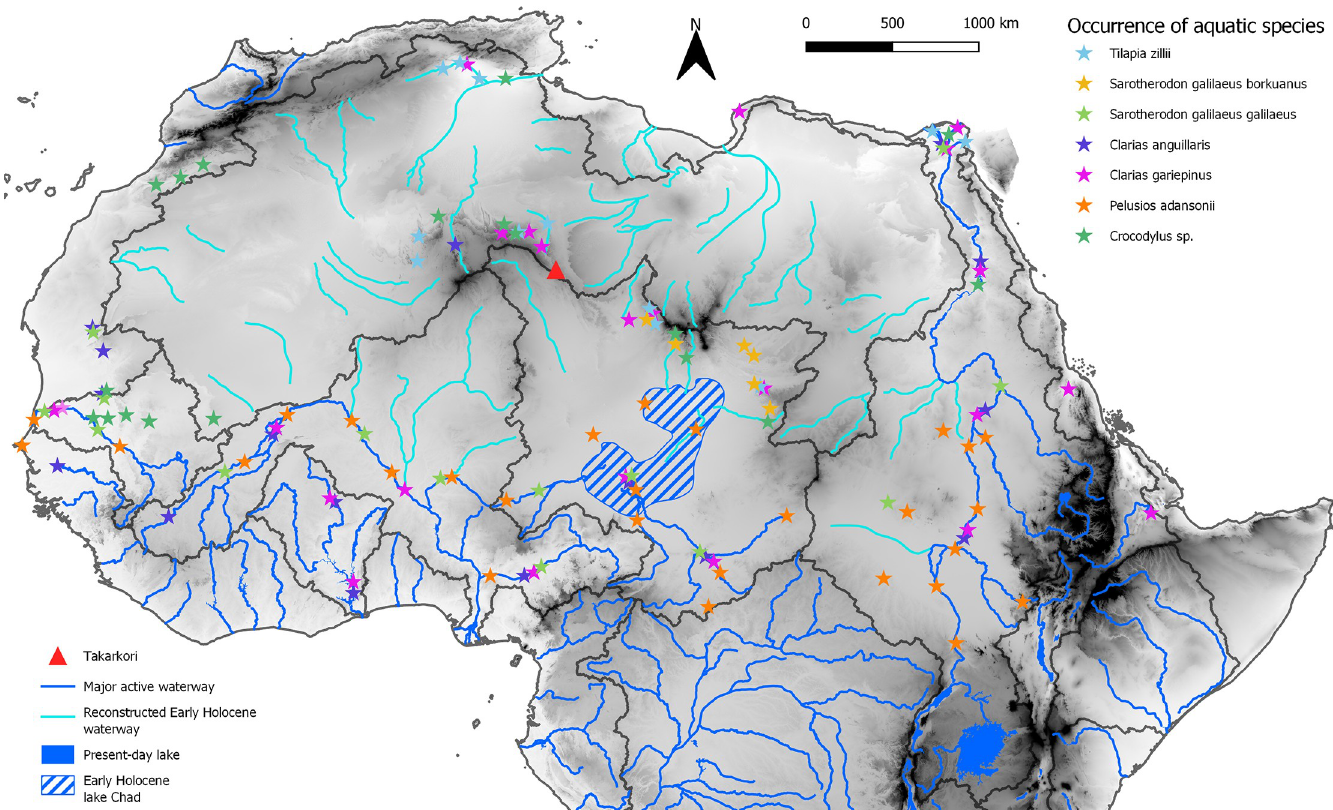
Fig 14. Extant occurrence of selected aquatic species (fish, crocodile, and turtle) in North Africa waterways (according to: Scortecci, 1937; Gautier and Van Neer, 1982; Le´v ê que, 1990; Bour, 2008; Brito et al., 2011). Crocodylus distribution has to be considered continuous in the present waterways south of the Sahara desert and along the Nile River south of